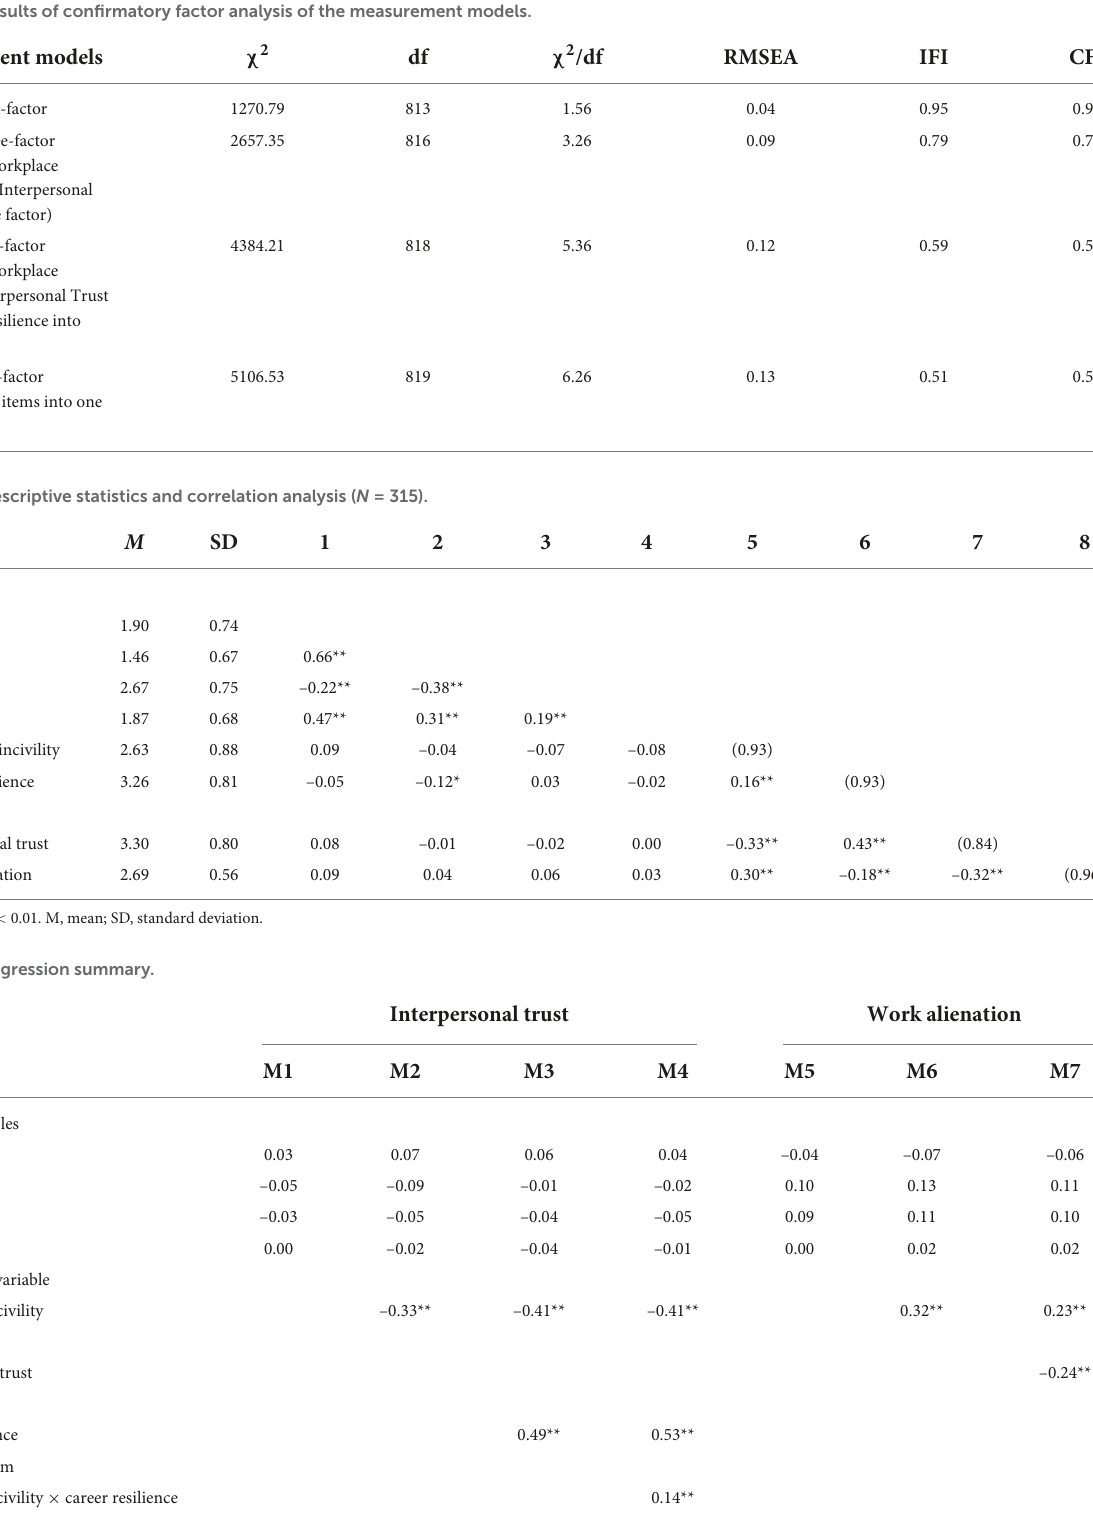
TABLE 1 Results of confirmatory factor analysis of the measurement models.